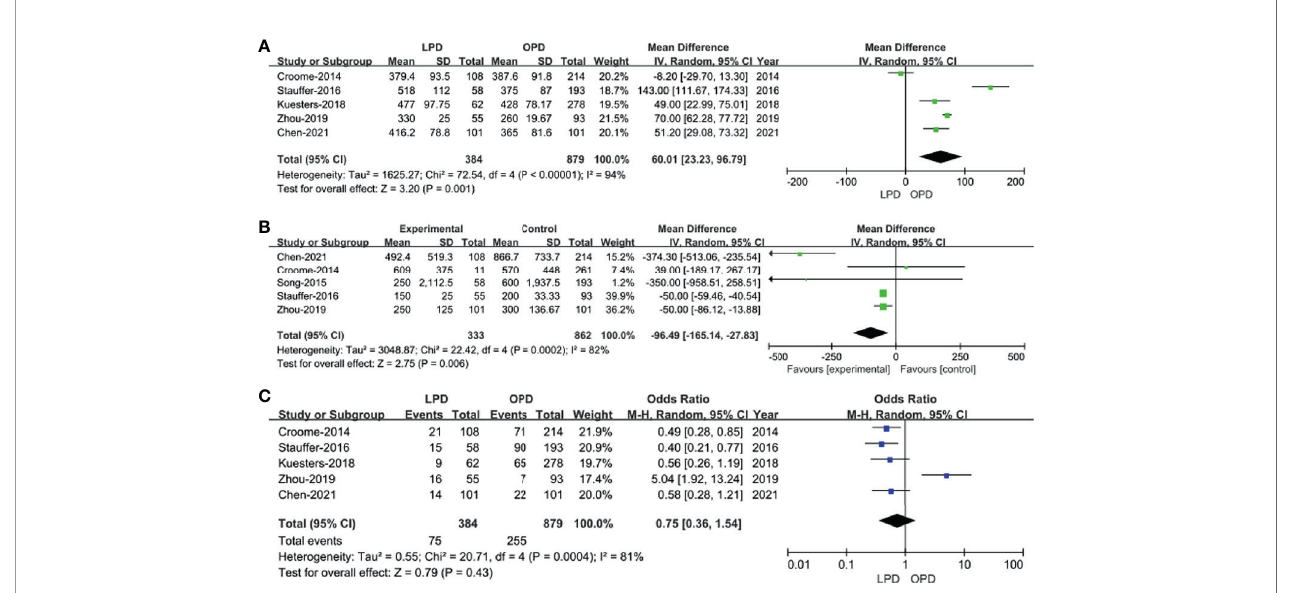
FIGURE 2 | Forest plot of the comparison of laparoscopic pancreaticoduodenectomy (LPD) versus open pancreaticoduodenectomy (OPD) for operative outcomes. (A) Forest plot for operative time; (B) forest plot for blood loss; (C) forest plot for blood